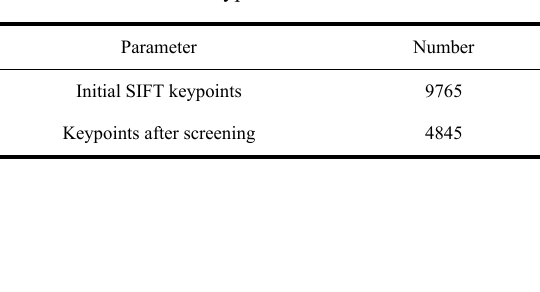
Fig. 7 Algorithmic performance: (a) the initial number of keypoints, (b) the number of keypoints with nonbuilding attributes, (c) the initial number of matching pairs, and (d) the number of precisely matched pairs. Table 1 Numbers of keypoints.